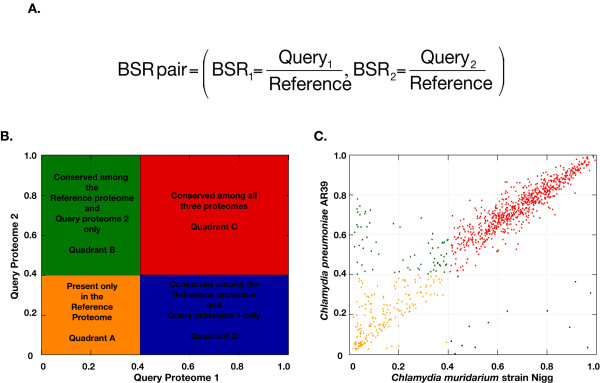
BSR rationale and scatter plot example. A. BLAST score ratio analysis (BSR) calculation demonstrating how the two coordinates for plotting in figures B and C are calculated. B. Locations of the peptide spot revels the similarity that the peptide has to the two Query genomes. Use of a 0.4 separator is based on ~30% amino acid identity over 30% of the length of the peptide [10]. C. Sample data obtained from comparison of Chlaymidia caviae GPIC (GenBank Accession Number AE015925) to the proteomes of Chlamydia muridarum strain Nigg (GenBank Accession Number AE002160) and Chlamydia pneumoniae AR39 (GenBank Accession Number AE002161) [17]. Each point in the figure represents a single peptide in Chlaymidia caviae GPIC This analysis reveals that while these organisms are very similar, C. caviae is more similar to C. pneumoniae AR39 than C. muridarum strain Nigg due the skew of peptides with a slope of greater than 1.